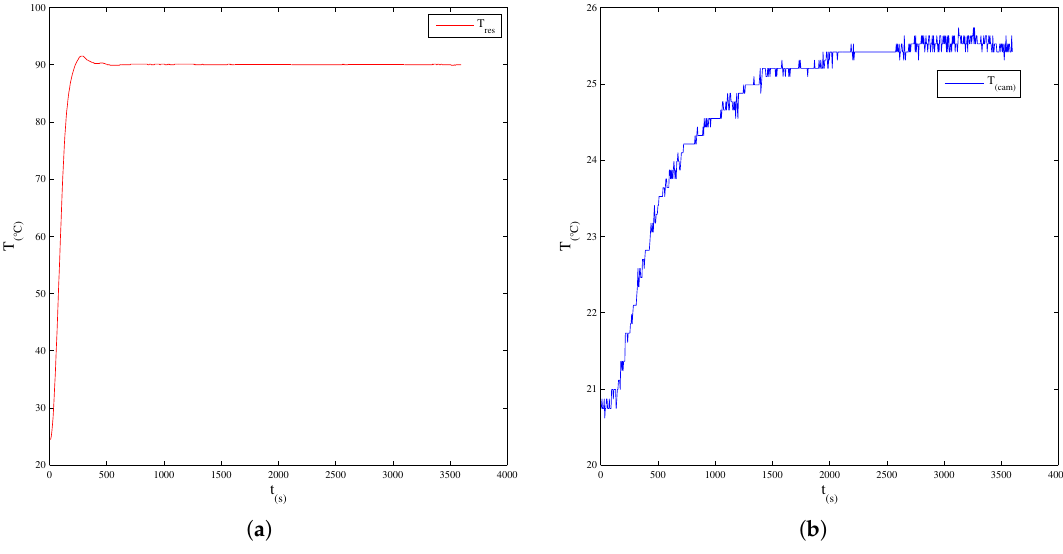
Figure 7. Examples of temperature curves in ( a ) the electrical resistence T res and ( b ) T cam the external side of the bamboo